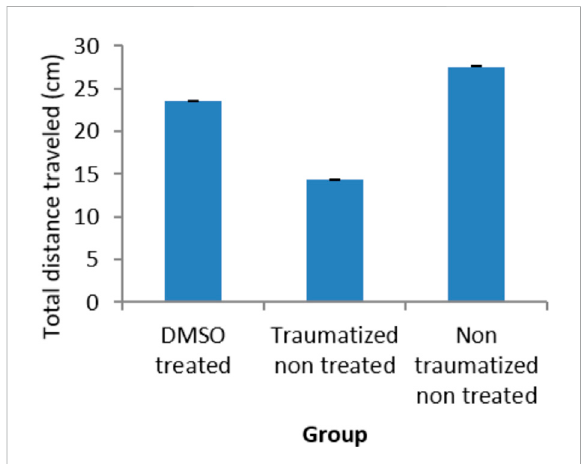
FIGURE 4 Effect of DMSO on locomotor activity in TBI induced rats; DMSO- dimethylsulfoxide, TNT- Traumatized Non-Treated, NTNT – Non traumatized Non treated. Data are expressed as the mean ± S.D. n = 7 per group. Data analyses were conducted using a one-way analysis of variance (ANOVA). Post hoc analyses were performed using Tukey ’ s multiple comparison tests when appropriate. * p < 0.05 compared to the traumatized non-treated